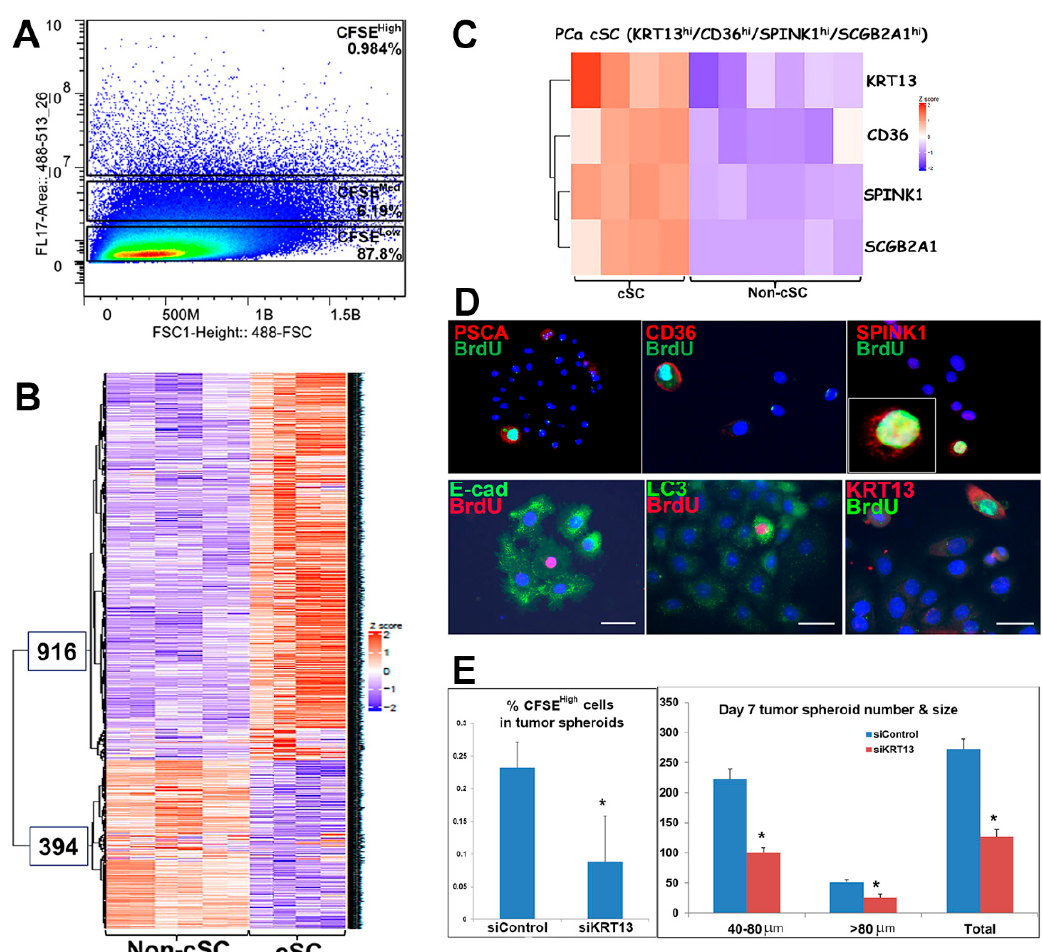
Figure 5. RNA-seq reveals differentially expressed genes in cancer stem-like cells and vs. non-stem cells in tumor spheroids of patient PCa specimens. ( A ) Cancer stem-like cells (cSC; (CFSE High ) and non-cSC (CFSE low ) from spheroids of three PCa specimens were separated by FACS. ( B ) Following RNA-seq of the sorted cells, unsupervised transcriptome profiling identified 1310 differentially expressed genes ( Q value < 0.05); 916 enriched in cSCs and 394 enriched in non-cSCs. Sequencing of the non-cSC fractions from three patients were performed in duplicate, highlighting data consistency. For the cSC fraction, one patient sample was sequenced in duplicate, and the other two were sequenced in singlet. ( C ) Heatmap of CD36, KRT13, SPINK1 , and SCGB2A1 expression shows enrichment in cSCs vs. non-cSCs. ( D ) ICC documents that PSCA, CD36, and SPINK1 proteins (red) colocalized with BrdU-labeled (green) cSC cells in the 3D cultured tumor spheroids. Similar to normal prostate stem cells, the cSCs exhibit decreased E-cadherin, increased LC3 and KRT13 (Hu et al., 2017), which together identifies unique features of PCa-derived cancer stem-like cells. (E) siRNA knockdown of KRT13 significantly decreased the percentage of CFSE High cells in tumor spheroids (left) and tumor spheroid formation (right). * p < 0.05 vs. siControl, N = 3. Table 1. Top genes enriched in prostate cancer stem-like cells. Gene